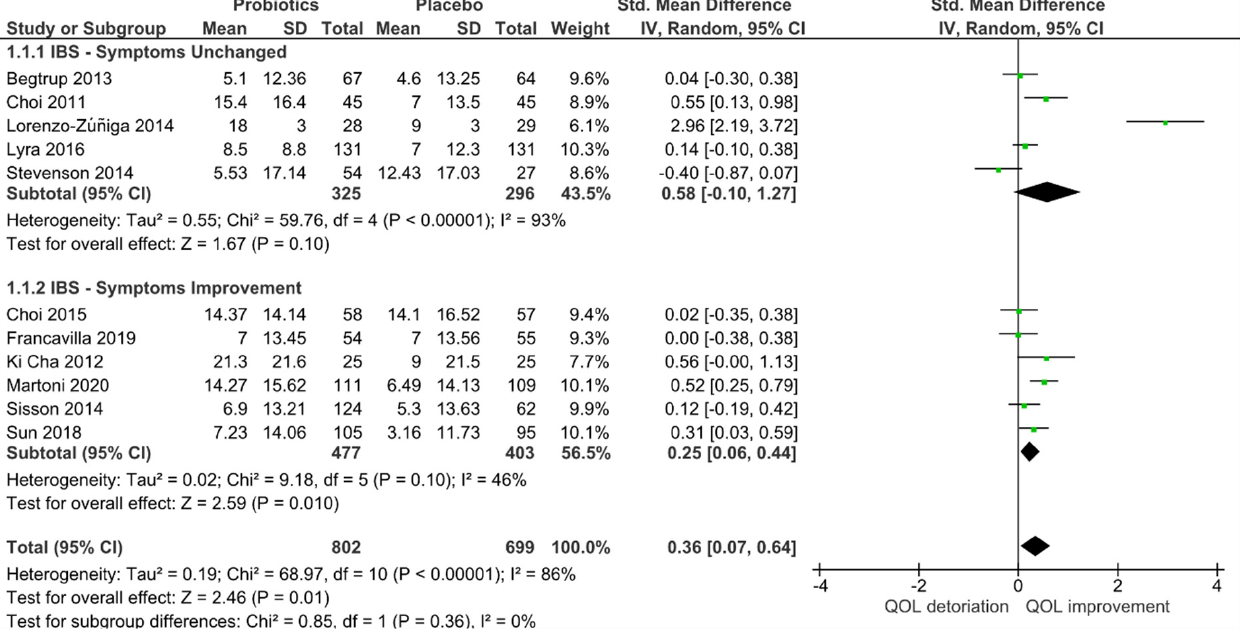
Figure 6. Effect of IBS symptom improvement on quality of life (QoL) of randomized controlled trials in IBS receiving either probiotics or placebo treatment. Table 3. Changes of symptoms for depression and anxiety compared between probiotic versus placebo intervention; HADS = Hospital Anxiety and Depression Scale. ↑ : symptom improvement p < 0.05 in probiotic versus placebo group; ↓ : symptom deterioration p < 0.05 in probiotic versus placebo group; ↔ : no group differences and no trend; ↔ (+): no group differences (trend towards symptom improvement); NR: not